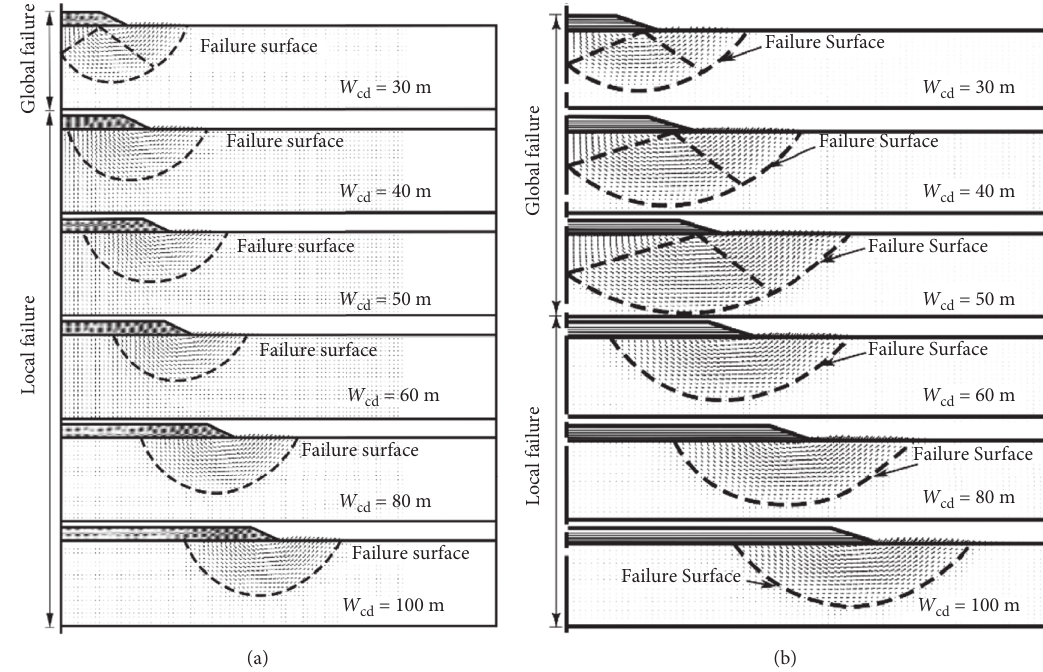
Figure 5: Soil heaving mechanism of different widths of large-scale sandbag cofferdams.